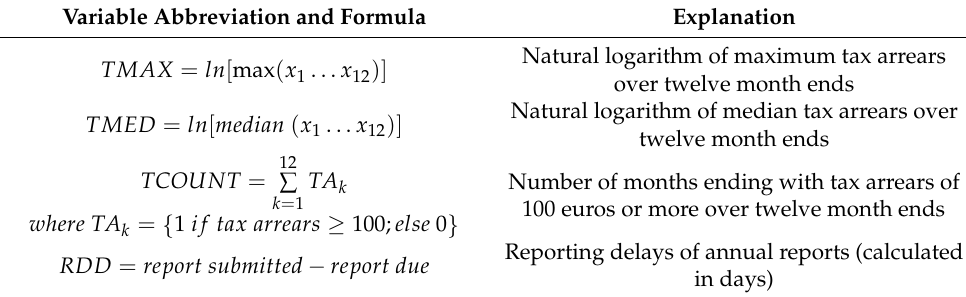
Table 3. Non-financial variables’ abbreviations, formulas and